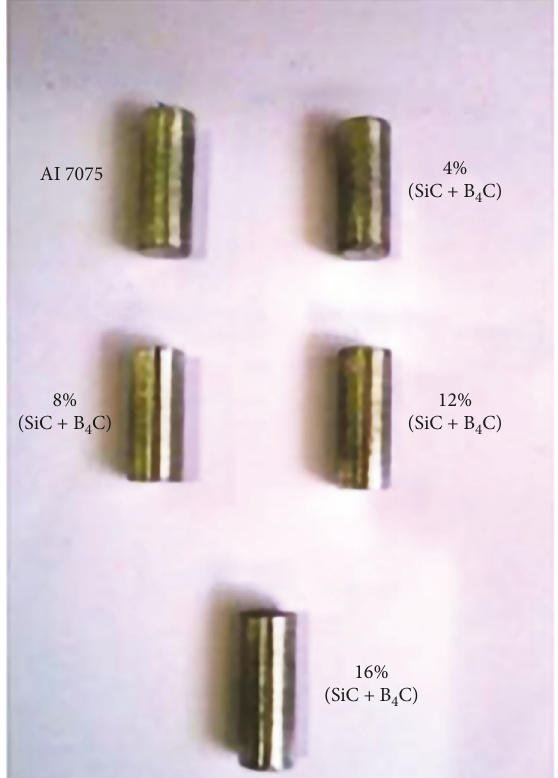
Figure 2: Samples for microstructure evaluation.